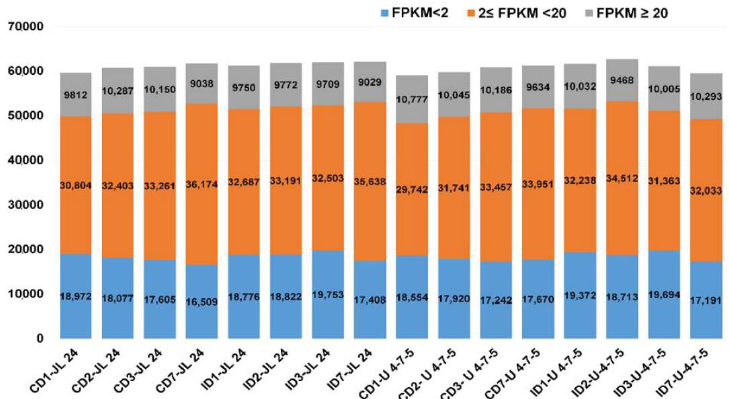
Figure 2. Distribution of genes expressed in JL 24 (susceptible genotype) and U 4-7-5 (resistant genotype). Three categories were grouped on the basis of Fragments Per Kilobase of exon per Million Reads Mapped (FPKM) value (FPKM<2, 2 ≤ FPKM < 20 and FPKM ≥20) in 16 samples at different time